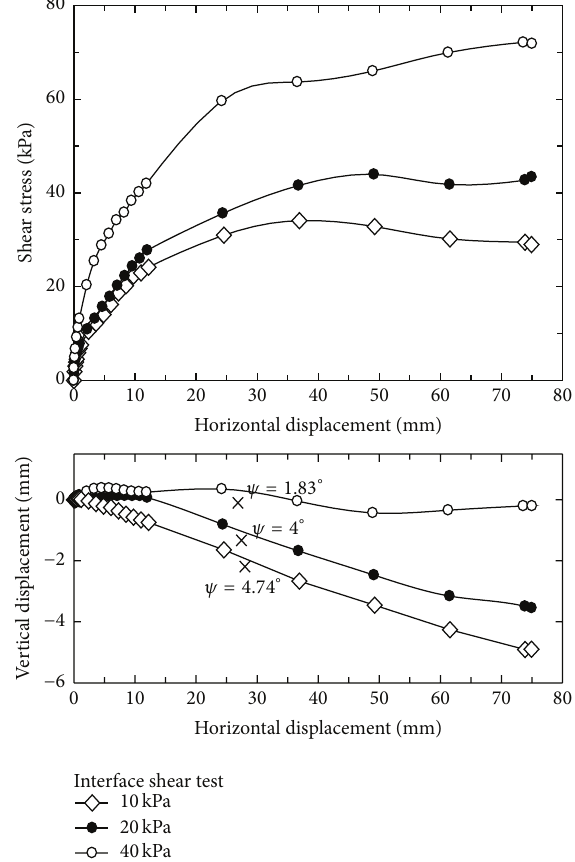
Figure 6: DST test results of geogrid reinforced